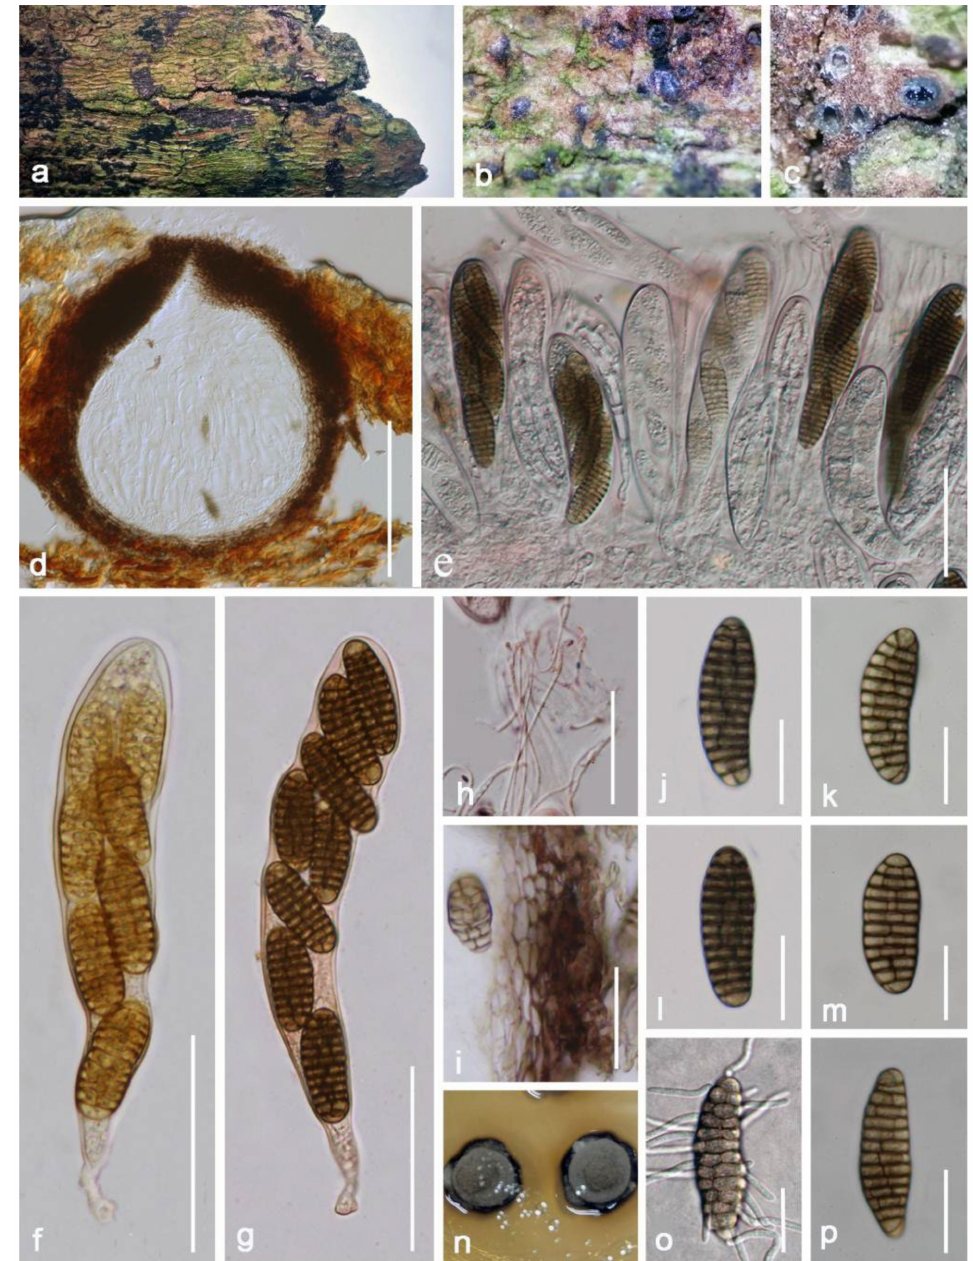
Figure 14. Phaeoseptum mali (HKAS 122193). ( a ) Ascomata on dead brunch of Mangifera indica ; ( b , c ) close-up of substrate; ( d ) section of ascoma; ( e – g ) immature and mature asci stained by congo red; ( h ) pseudoparaphyses stained by congo red; ( i ) peridium; ( j – m , p ) ascospores; ( n ) colonies on PDA; ( o ) germinated ascospore. Scale bars: ( d ) = 150 µ m; ( f , g ) = 50 µ m; ( h ) = 40 µ m; ( i , o ) = 20 µ m; ( j – m , p ) = 15 µ